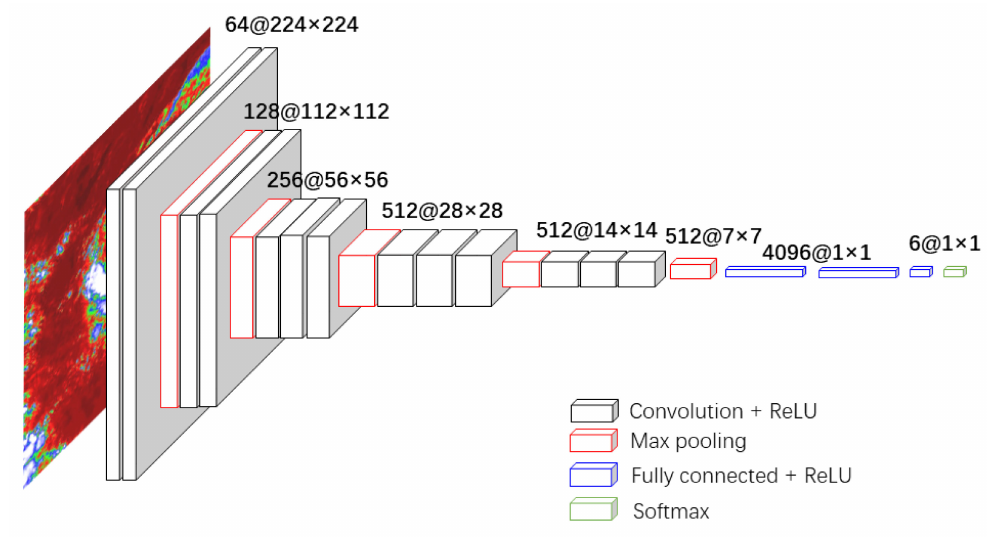
Figure A2. The overall structure of the VGG16